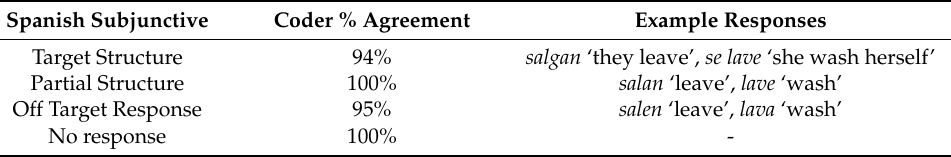
Table 4. Sample of Coded Responses—Spanish Present